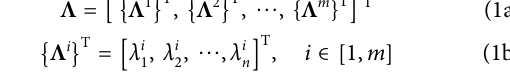
Frontiers in Built Environment |